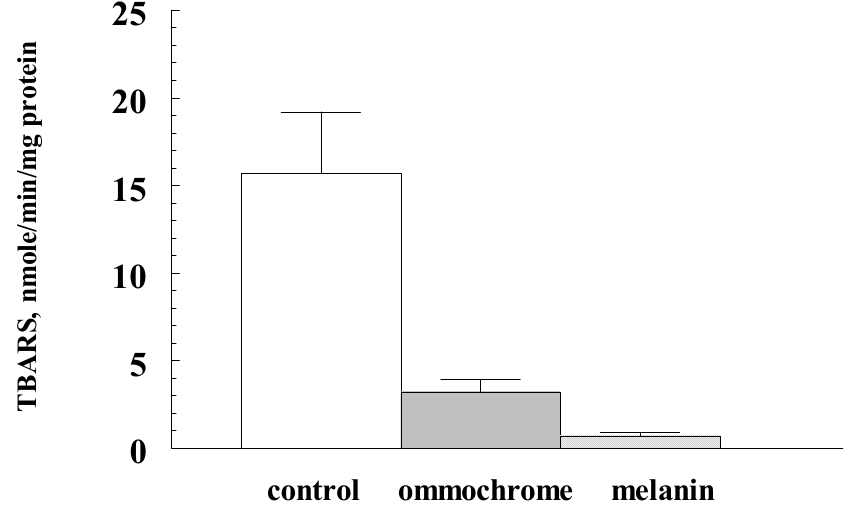
Figure 5. The inhibitory e ff ect of delipidated form of water-soluble melanin (DL-WSM) and BSF’s ommochromes on the peroxidation process of the outer segments of the photoreceptor cells of a bull’s eye. The control—without the addition of pigments; experiment—added 0.35 mg / mL ommochromes and 0.4 mg / mL melanin. The ordinate axis—rate of accumulation of TBA-reactive products (TBARS) in nmol / mg protein per 1 min. Data are means (means ± SD) of three assays, p <